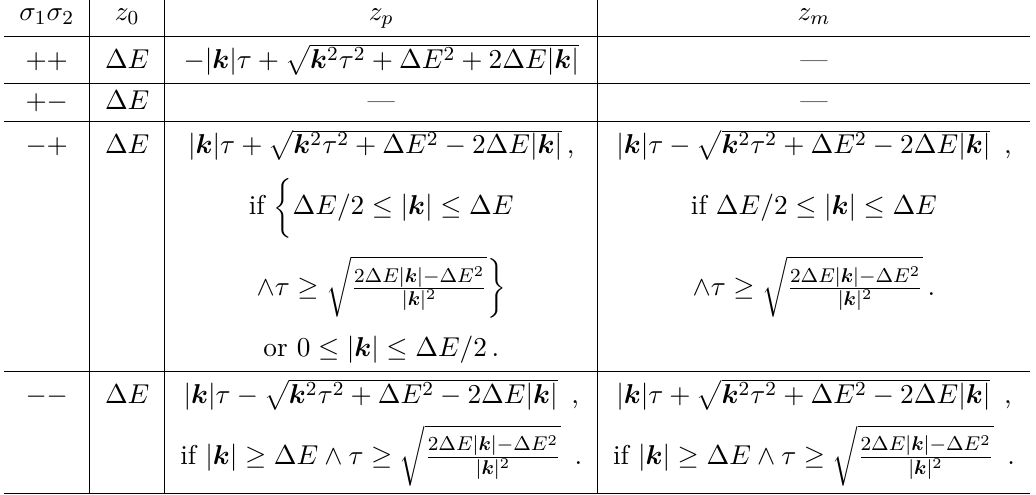
Table 7. Summary of the single ( z